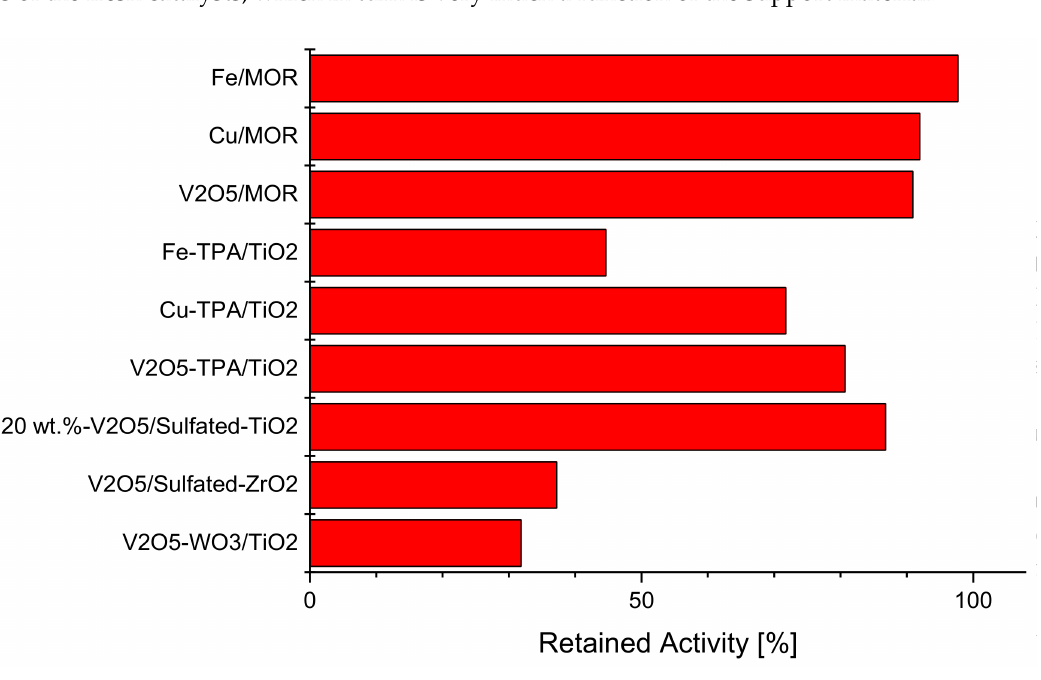
. (130 µ mol K g − 1 catalyst catalyst